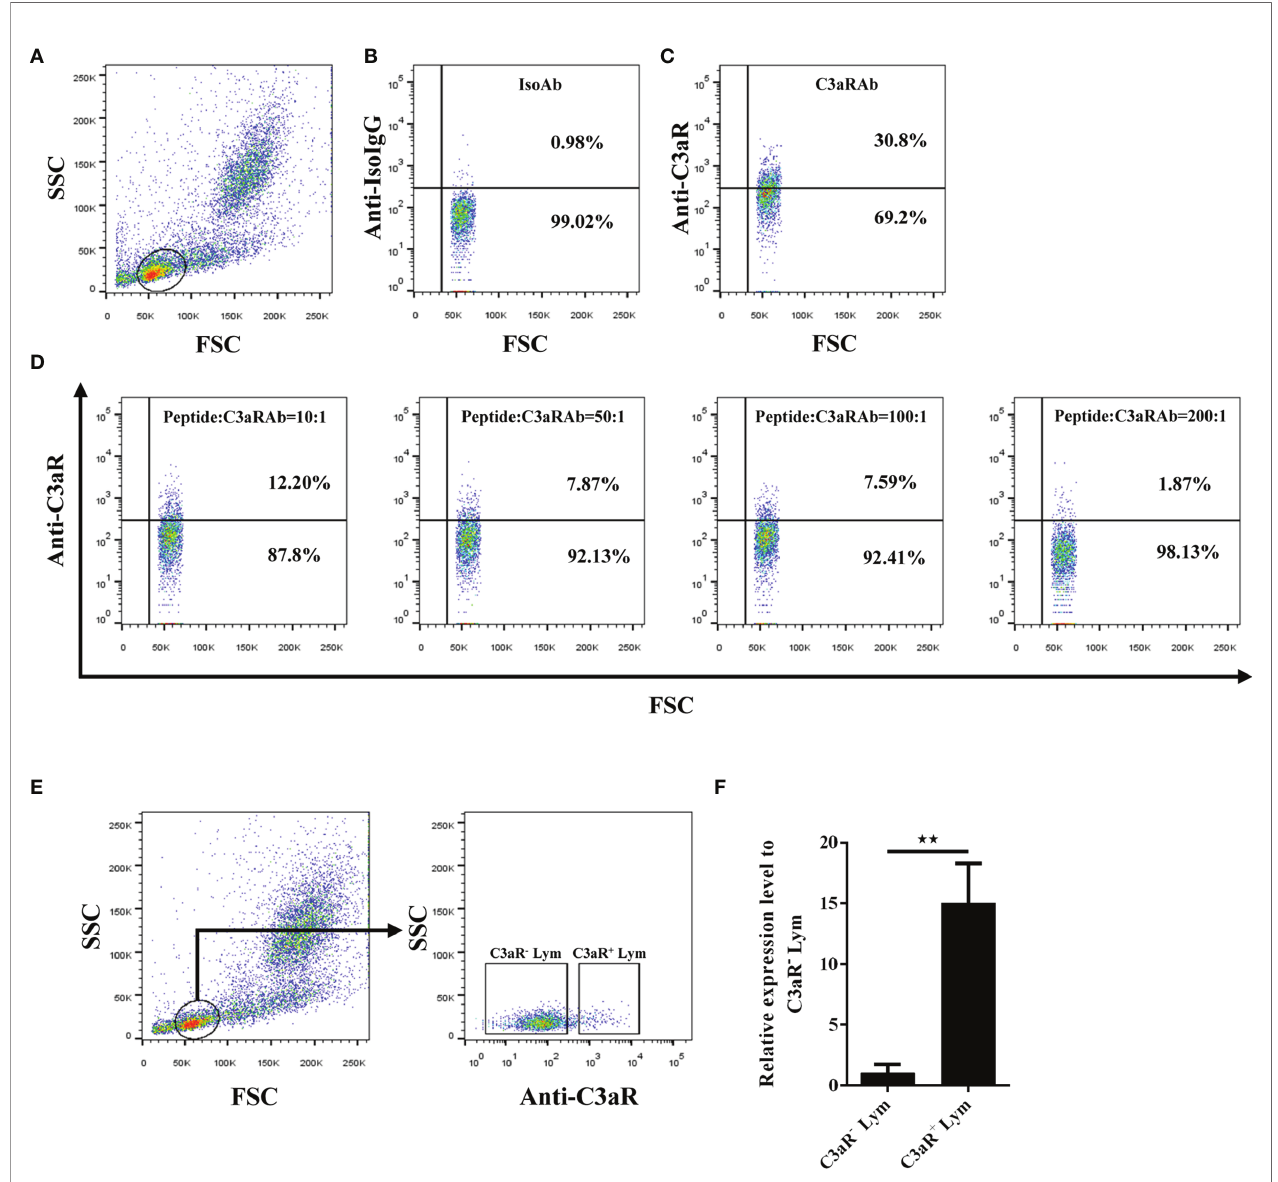
FIGURE 7 | Detection of the speci fi city of the rabbit anti-C3aR pAbs. (A – D) Blocking of the anti-C3aR pAbs by preincubation with the antigenic peptide used for pAb development. (A) Gating strategy for fl ow cytometry analysis of HKLs stained with rabbit anti-C3aR pAbs. The lymphocytes (Lym) were gated to further analyze the C3aR positive cells. (B) Lym in HKLs stained with rabbit IgG isotype control Abs. (C) Lym in HKLs stained with rabbit anti-C3aR pAbs. (D) Lym in HKLs stained with peptide-preincubated rabbit anti-C3aR pAbs. The rabbit anti-C3aR pAbs were preincubated with the peptide at different molar ratios for 30 min, then stained HKLs for fl ow cytometry. (E, F) Expression of C3aR in C3aR + Lym and C3aR - Lym. (E) Sorting of C3aR + Lym and C3aR - Lym by FACS. HKLs were stained with rabbit anti-C3aR pAbs, then C3aR + Lym and C3aR - Lym were sorted and subjected to RNA isolation and cDNA synthesis. (F) The mRNA expression level of C3aR in C3aR + Lym and C3aR - Lym. The mRNA expression level of C3aR in C3aR + Lym and C3aR - Lym was analyzed by qPCR and normalized against the expression of b -actin using the 2 − D Ct method. One representative result was shown in (A – E) . Data in (F) are presented as mean ± SEM (n = 5 fi sh), and the statistic p value was calculated by one-way ANOVA with a Dunnett post hoc test (** p <